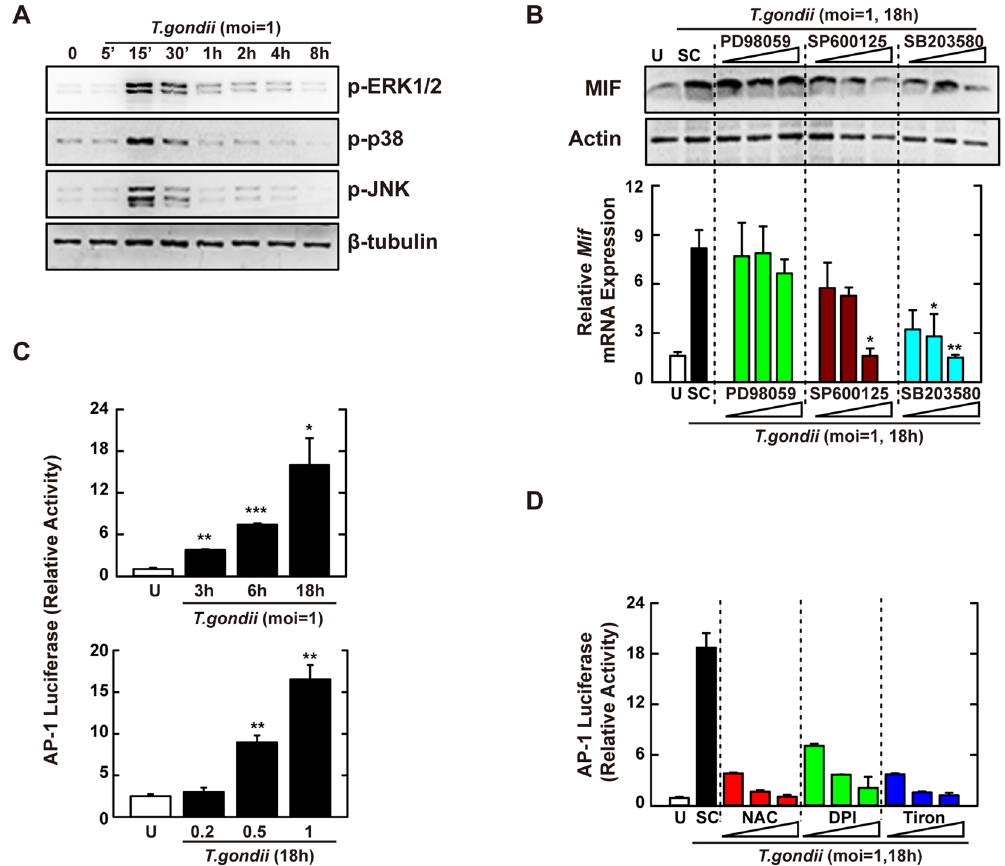
Figure 2. T . gondii -induced MIF expression is mediated through the activation of JNK and p38 MAPK pathway, followed by the AP-1 transcriptional activation. ( A ) BMDMs were infected with T . gondii RH strain (moi = 1) for the indicated time periods. Cells were harvested and subjected to western blotting analysis for phosphorylated ERK, p38, or JNK. β -tubulin served as a loading control. ( B ) BMDMs were pretreated with PD98059 (5, 10, 20 μ M), SP600125 (5, 20, 30 μ M) or SB203580 (1, 5, 10 μ M) for 45 min, followed by infection with T . gondii RH strain (moi = 1) for 18 h. Immunoblot (top) or qPCR (bottom) analysis was performed to determine protein and mRNA expression MIF, respectively. ( C ) Raw 264.7 cells were transfected with plasmids carrying AP-1 luciferase reporter constructs before T . gondii RH strain (moi = 1, top; indicated moi, bottom) for various time periods (top) or 18 h. Luciferase assays were performed based on normalization to the β -galactosidase activity. ( D ) Effects on AP-1 transcriptional activity in the presence or absence of general antioxidant (NAC; 1, 2, or 5 mM), Nox inhibitor (DPI; 1, 5, or 10 μ M) or superoxide scavenger (Tiron; 5, 10, or 20 mM). The experimental conditions were as outlined in Fig. 2C. Data are representative of three independent experiments and are presented as means ± SD. * P < 0.05, ** P < 0.01, *** P < 0.001, two-tailed Student’s